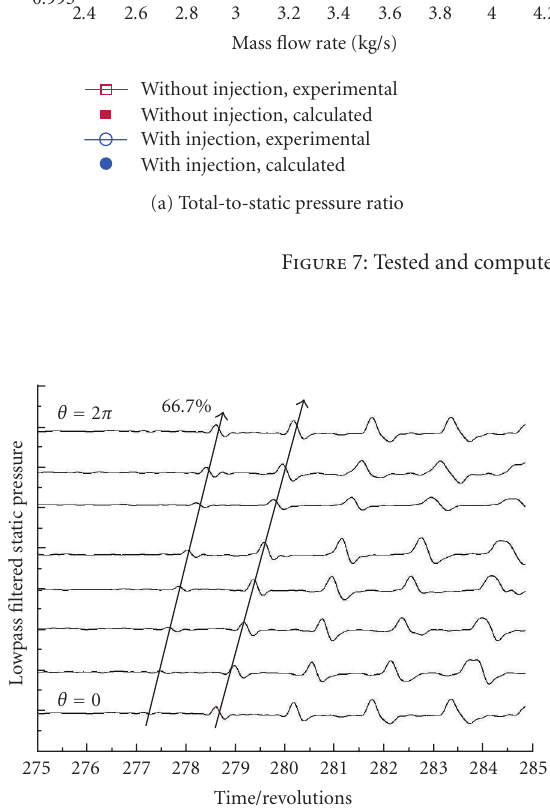
Figure 8: Stalling pattern of research